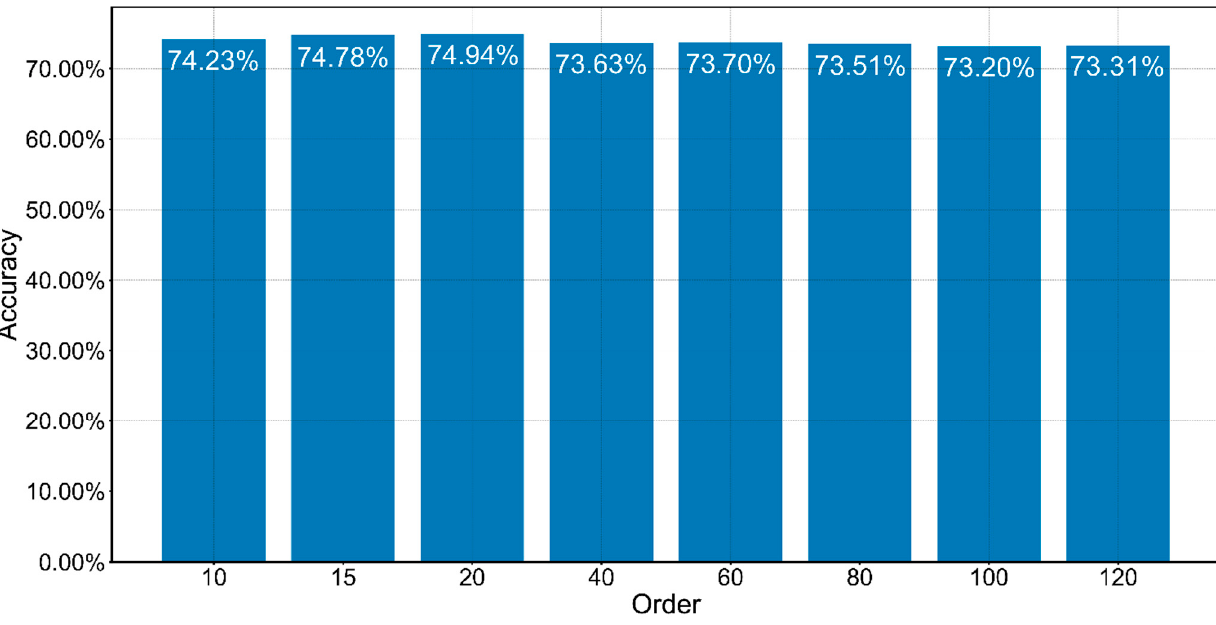
Table 4. Performance comparison between the proposed method, CNN, SVM, RF, FLDA, KNN, and GRU. The best results are shown in bold font. Method